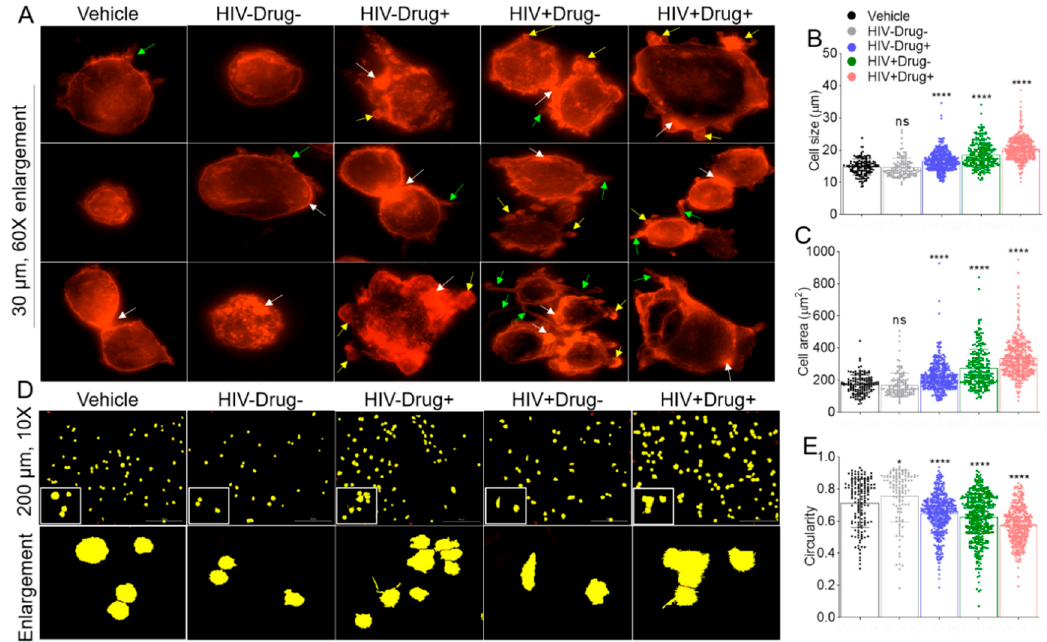
Figure 6. Altered monocyte morphometrics following treatment with SE from participants who used psychostimulants and/or were infected with HIV: ( A ) 60× fluorescence images of U937 monocytes plated atop collagen, treated with vehicle and different SEs as indicated in the figure, and stained with phalloidin to visualize actin membrane structures. Cells treated with SE-Drug or SE-HIV had distinct changes in morphology and exhibited significant membrane ruffles and filopodia-like extensions. White arrows indicate areas of increased F-actin localization. Green arrows indicate filopodia-like structures. Yellow arrows indicate membrane ruffles. Scale bar = 30 µm. The membrane tracing was used to assess monocyte circularity. The white box corresponds to the enlarged area. Scale bar is 200 µm. ( B ) Scatterplot of cell size. ( C ) Scatterplot of cell area. ( D ) Ten times representative membrane tracing (with fill) images of vehicle and different SE treatments obtained with the Lionheart FX Gen5 software. ( E ) Scatter plot of cell circularity. Calculations were performed by Lionheart FX Gen5 software. Ordinary one-way ANOVA (Dunnett’s correction) was used to determine the significance of SE treatments relative to vehicle. * P < 0.05, ** P < 0.01, *** P < 0.005, **** P < 0.001, and ns, nonsignificant.